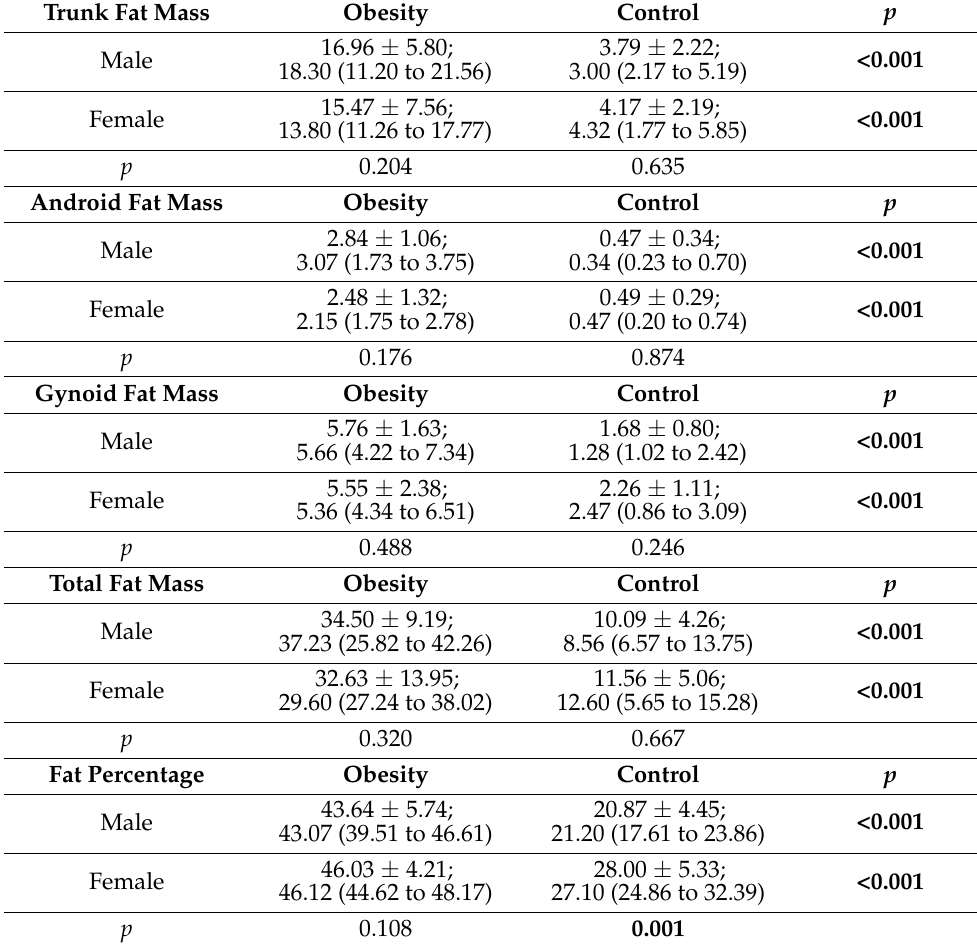
Table 6. Association between body composition (fat mass) evaluated by dual-energy X-ray absorp- tiometry in groups of participants with and without obesity and according to sex.